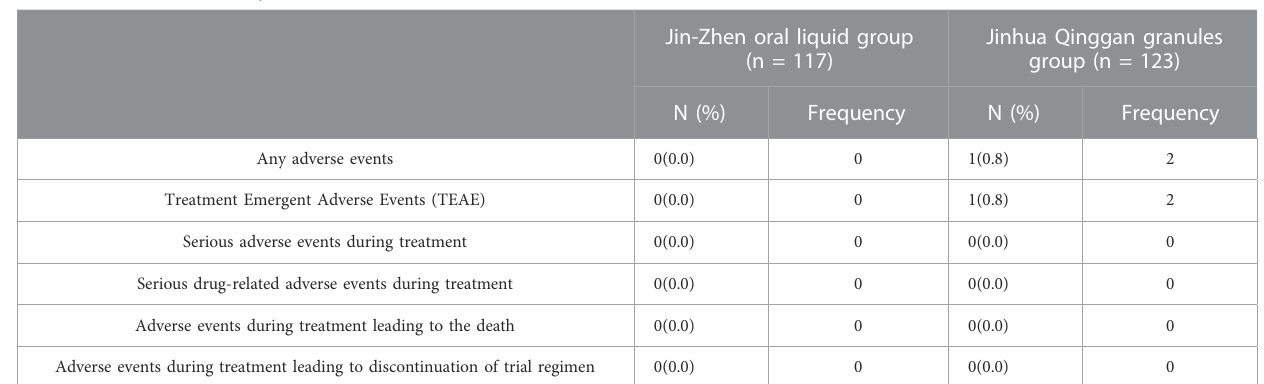
TABLE 6 Adverse events (Safety set).